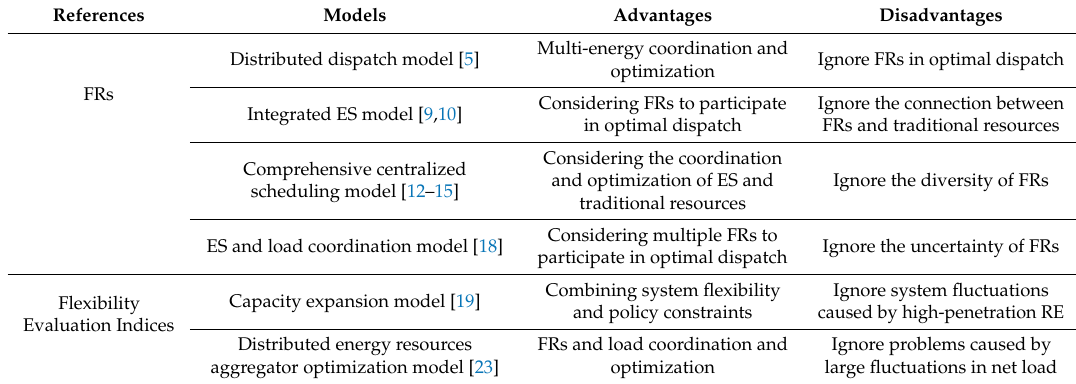
Table 1. Advantages and disadvantages of research on power system